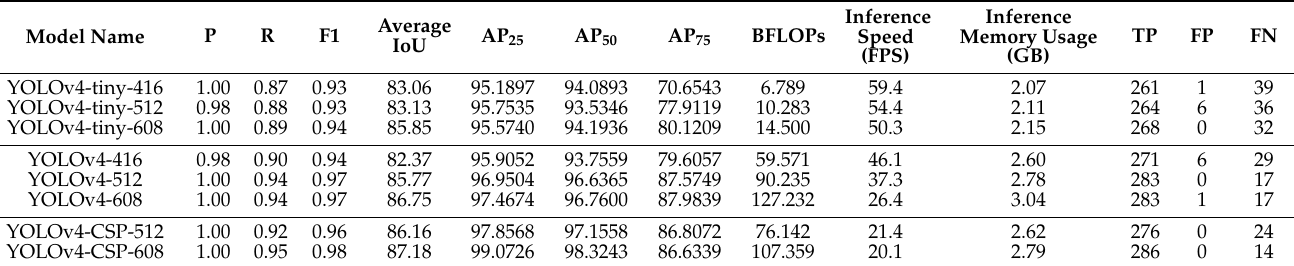
Table A3. Performance metrics of the YOLOv4 models on the Test Dataset (Complete).